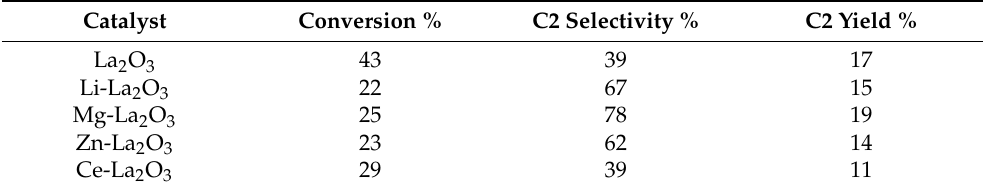
Table 3. Catalytic Performances of X-La 2 O 3 for OCM (T: 760 ◦ C; C2: ethane and